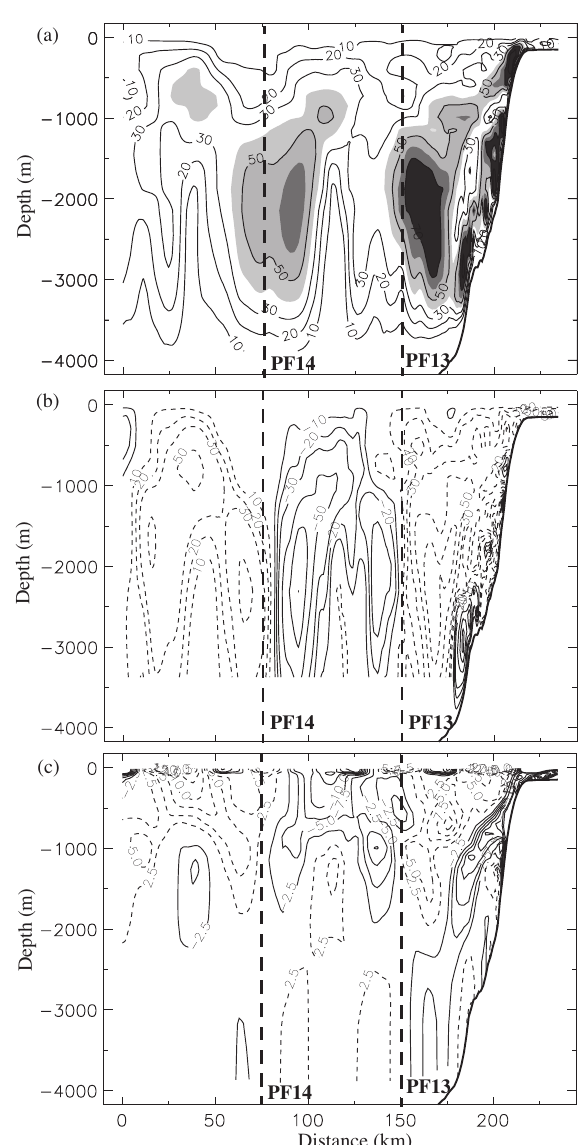
F IG . 11. – (a) Distribution of the internal tide amplitude along sec- tion S3 from 7.32°W 45.66°N (PF15) to 5.8°W 47.4°N (close to DP942), calculated as for section S (Fig. 7b). (b) Distribution of the interface elevations along S3 on 06/10 at 6 h (the same tidal hour as for Fig. 10). (c) Distribution of the total across-slope velocity along on 06/10 at 6 h. The angle between the normal to the bottom slope and the north is 16 o . Dotted lines are negative values, dashed lines are positive